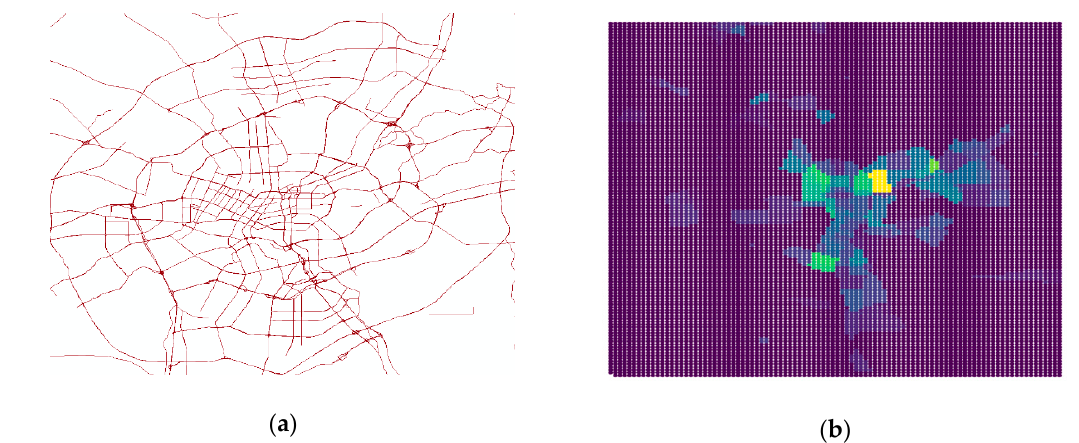
Figure 4. ( a ) Schematic of the urban area in the City of Shenyang with roads. ( b ) The plot ratio data after rasterization. Data processing has many steps, including map acquisition, data matching, grid transformation, window sampling and batch splitting. After batch splitting, a sliding window (9 × 9 grids) was used to sample the data and reshape them into bi-dimensional tensors, resulting in 10,092 windows in the study area. As shown in Figure 5, the windows were selected by a zero rate index, which means a window is marked as unusable when 80% of the data in the window is missing for lack of information. Among them, 100 randomly selected windows are used as the test dataset, and the remaining 9992 windows are used as the training dataset.